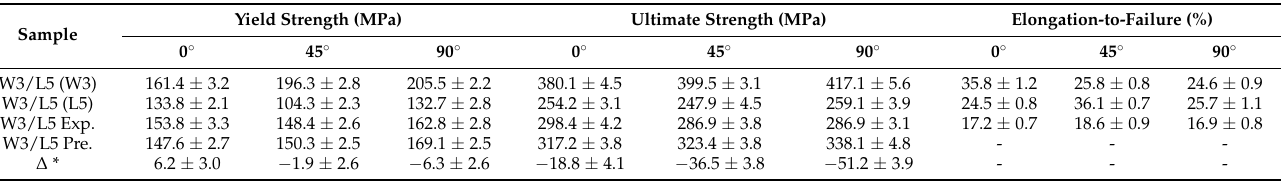
Figure 4. True tensile stress-strain curves of W3 layer ( a ), L5 layer ( b ) and W3/L5 laminated composite ( c ) at RT along 0 ◦ , 45 ◦ and 90 ◦ ; ( d ) view of high magnification from black frame in ( c ). Table 1. Experimented and predicted tensile properties of W3 layer, L5 layer and W3/L5 laminated composite along 0 ◦ , 45 ◦ and 90 ◦ at